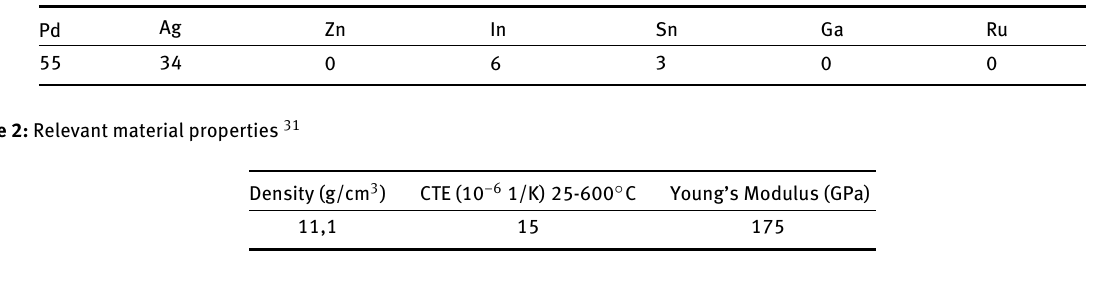
Table 1: Base alloy composition (wt%)